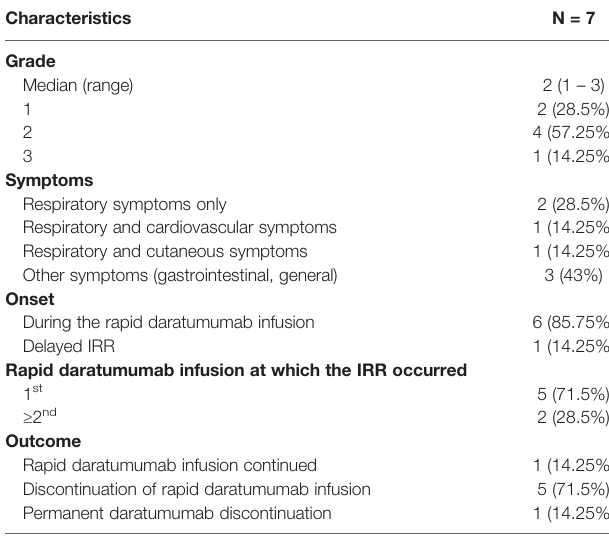
TABLE 2 | Infusion-related reactions with rapid daratumumab infusion